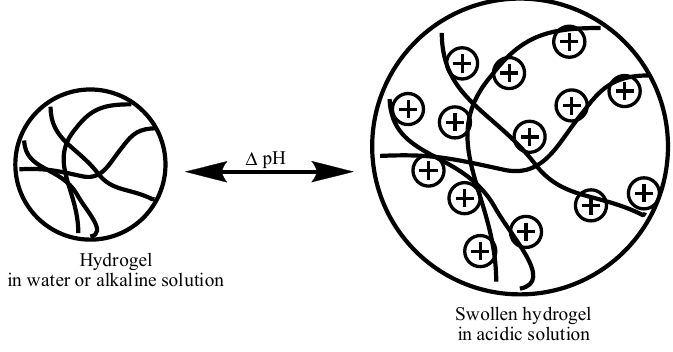
Figure 2. Swelling of hydrogel in acidic solution due to the formation of fixed charges on the polymer network. Figure 3. Chemical structure of cationic polymers (1) poly(dimethylaminoethyl methacrylate) (PDMAEMA); (2) poly(diethylaminoethyl methacrylate) (PDEAEMA); (3) poly(ethyl pyrrolidine methacrylate) (PEP); (4) poly(ethyl piperazine acrylate) (PAcrNEP).